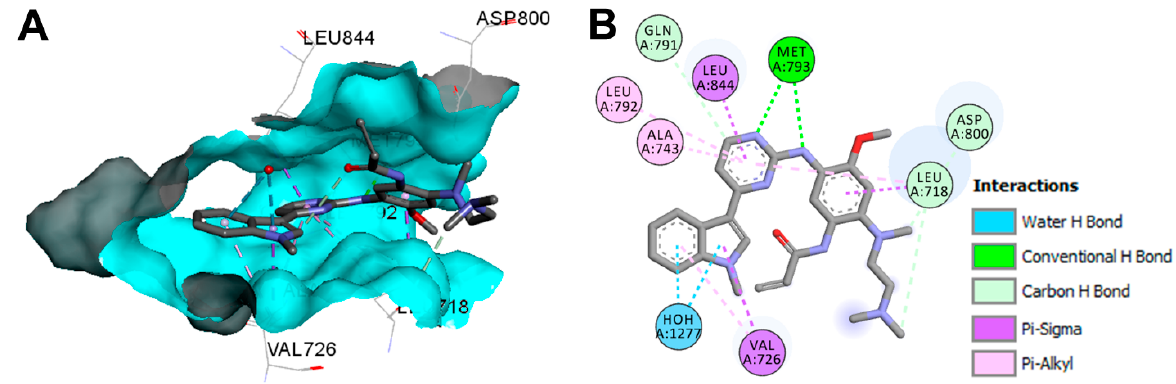
Figure 54. Binding modes of osimertinib (shown as sticks) into EGFR 696-1022 T790M (pdb: 6JX0): ( A ) 3D binding mode, receptor shown as hydrogen bond surface; ( B ) 2D binding mode showing different types of binding interactions; the figure was generated using Discovery Studio Visualizer (V16.1.0.15350).